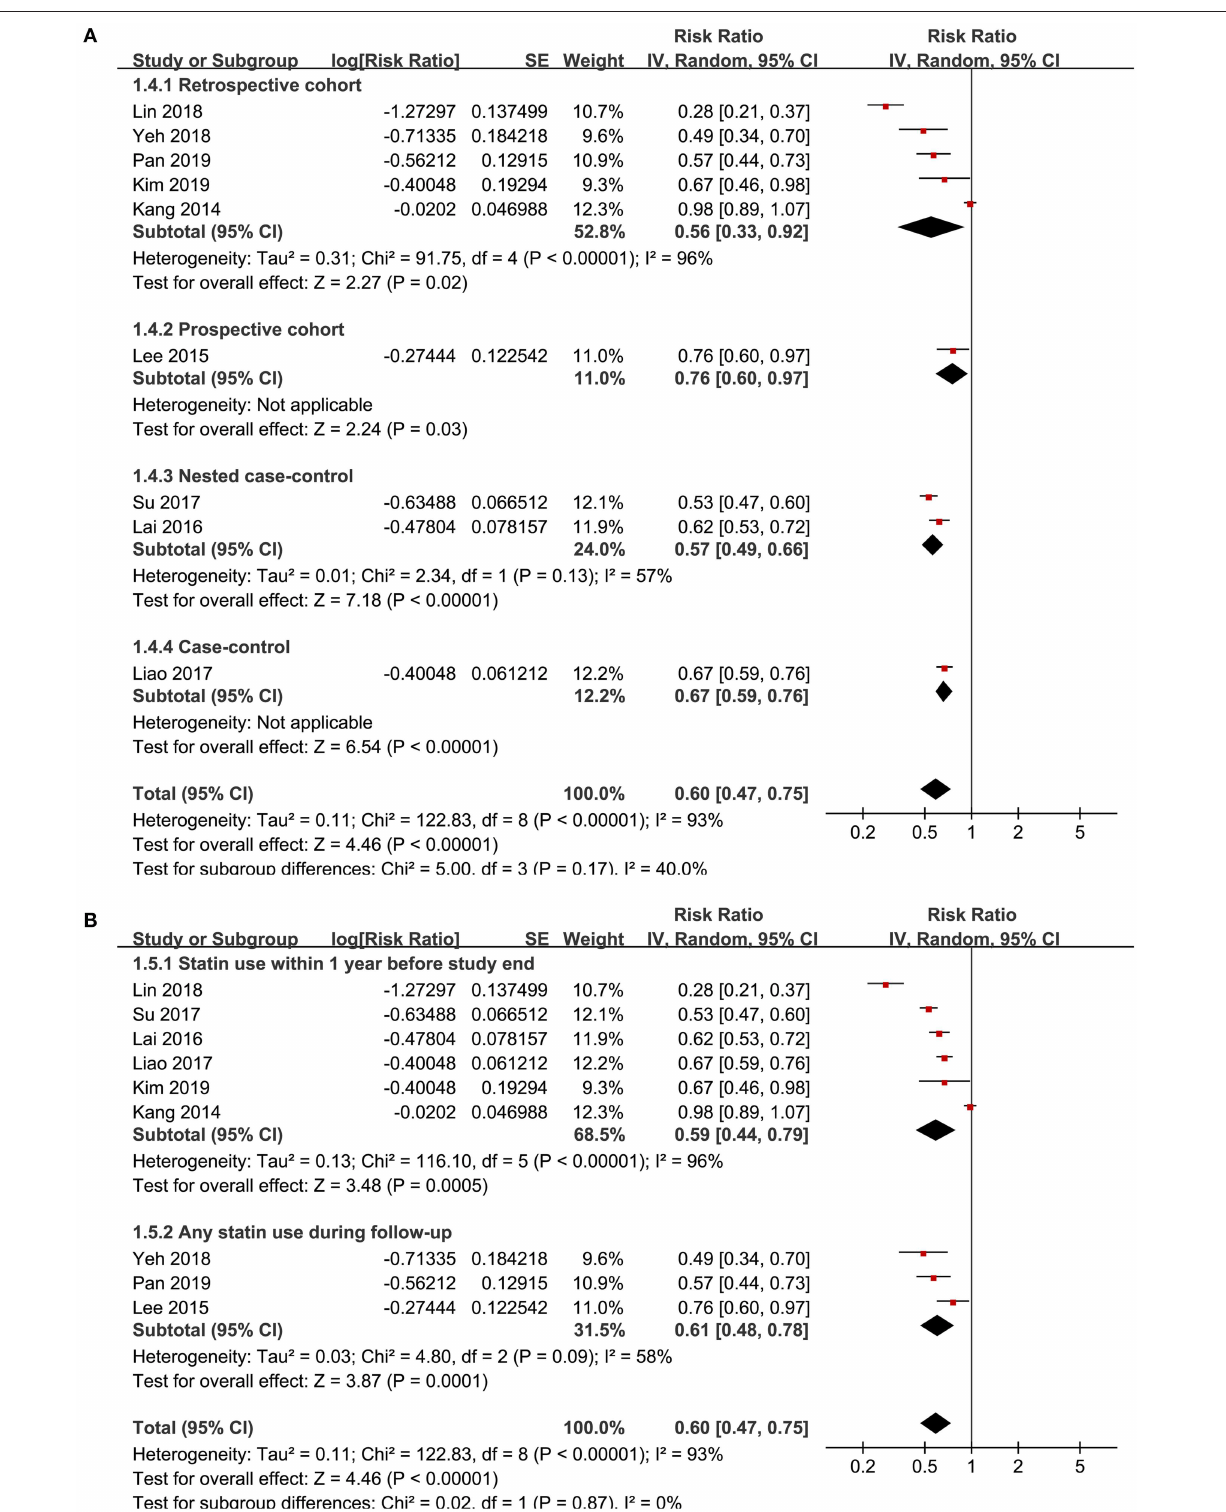
Frontiers in Medicine |